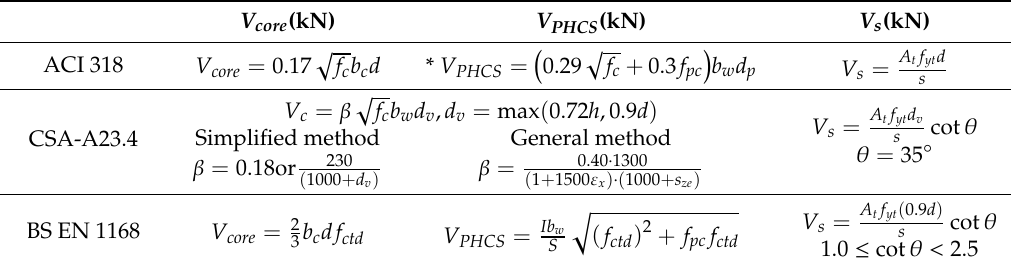
Table 1. Code equations for estimating shear strength of reinforced concrete (RC) and prestressed concrete (PSC)